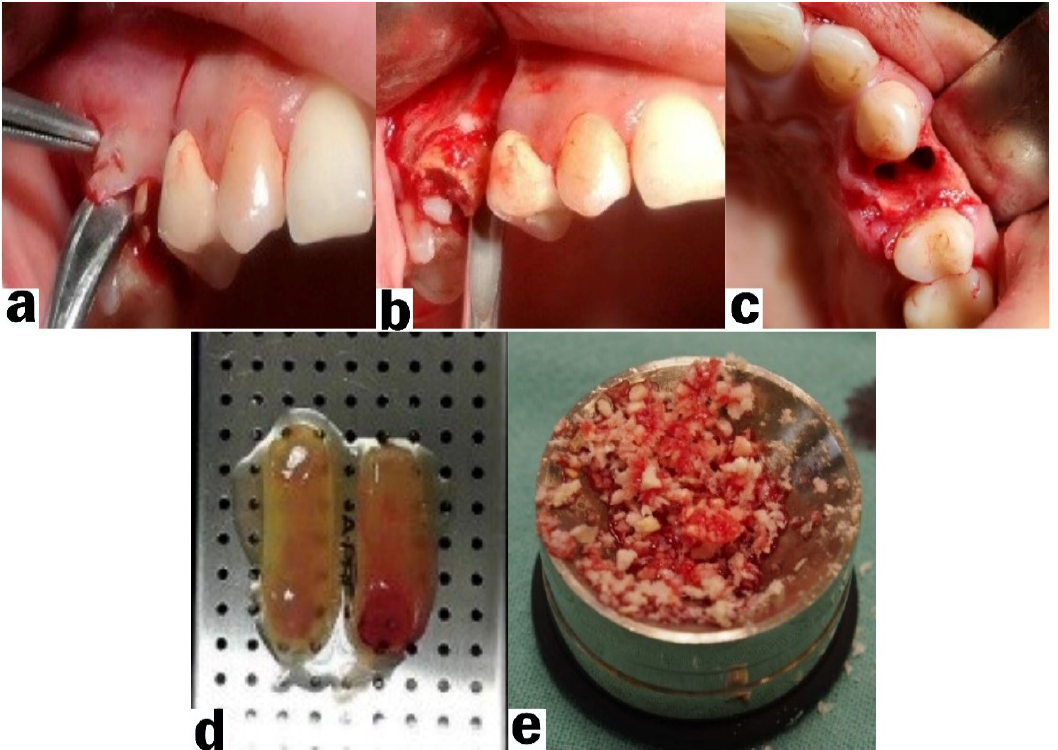
Figure 2 . Socket preservation—tooth extraction protocol: ( a ) elevation of a mucoperiosteal flap; ( b ) tooth extraction; ( c ) post-extraction socket and grafting materials used: ( d ) PRF ( e ) Bone graft containing FDBA mixed with blood.